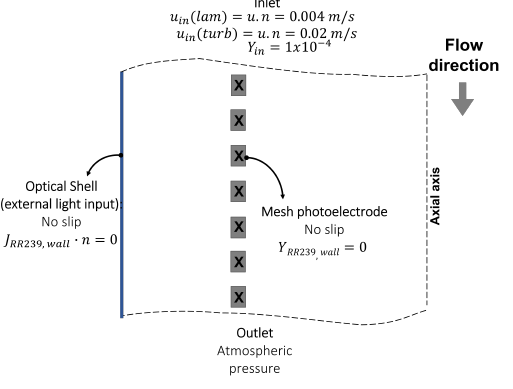
Figure 1. Boundary conditions for studying the mass transfer flux rate. The boundary conditions for the momentum and species transport model are as fol-